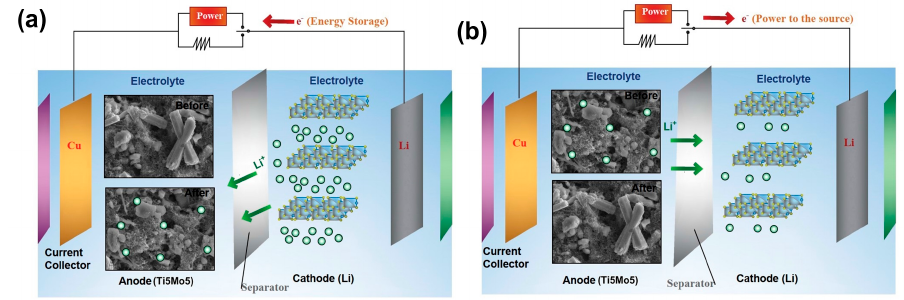
/ DMC | Ti5Mo5 battery: ( a ) charging process and ( b ) discharging Figure 1. Li | LiPF 6 in EC/DMC | Ti5Mo5 battery: ( a ) charging process and ( b ) discharging process. Figure 1. Li | LiPF 6 in EC